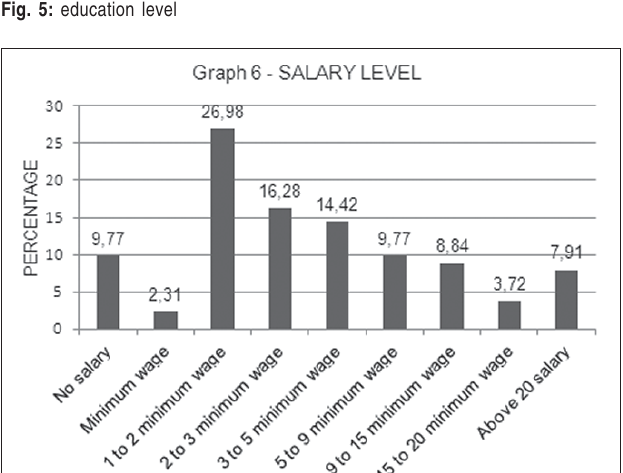
Fig. 5: education level